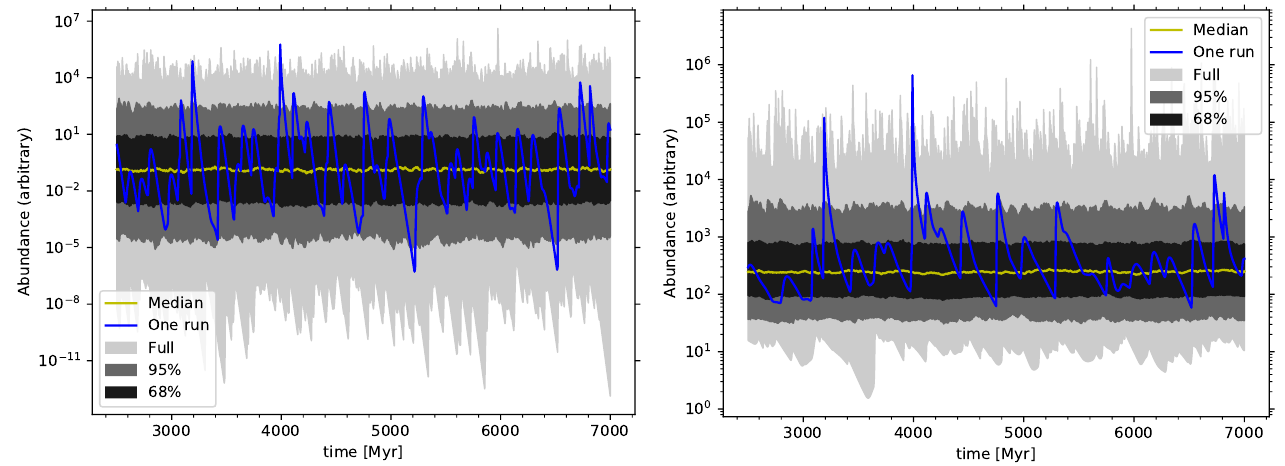
Figure 6. Hotokezaka-style model example calculations showing the abundance evolution in time of an SLR nucleus in the ISM. For the 1000 runs calculated for this example, the median (yellow line), 1 σ (black region), 2 σ (dark grey), and total (light grey) distribution are shown, as well as one example case (blue line). The set-up represents the case of a stellar source with a constant total galactic rate of 15 events per Myr (compatible to the current neutron-star merger rate), ISM mixing length α = 0.1, and turbulent velocity of 7 km/s. The mass of SLR nucleus ejected by each event is the numerical value 1 (if multiplied by M (cid:12) , then the y-axis can be considered in units of M (cid:12) ). The left and right panels represent the case of an SLR nucleus with τ = 10 and 100 Myr, respectively, and the abundances can be compared to each other. The median for τ = 10 Myr is roughly 3 orders of magnitude lower than that for τ = 100 Myr, because the longer τ allows for the SLR nucleus to accumulate. The spread, e.g., at 68%, is 2 to 3 orders of magnitudes larger for τ = 10 Myr than for τ = 100 Myr, which reflects the impact of the faster decay. The peaks in the single case, blue lines are more spaced out in the τ = 100 Myr case because the slower decay and memory build up produces a higher median abundance; therefore, some of the events do not have a visible